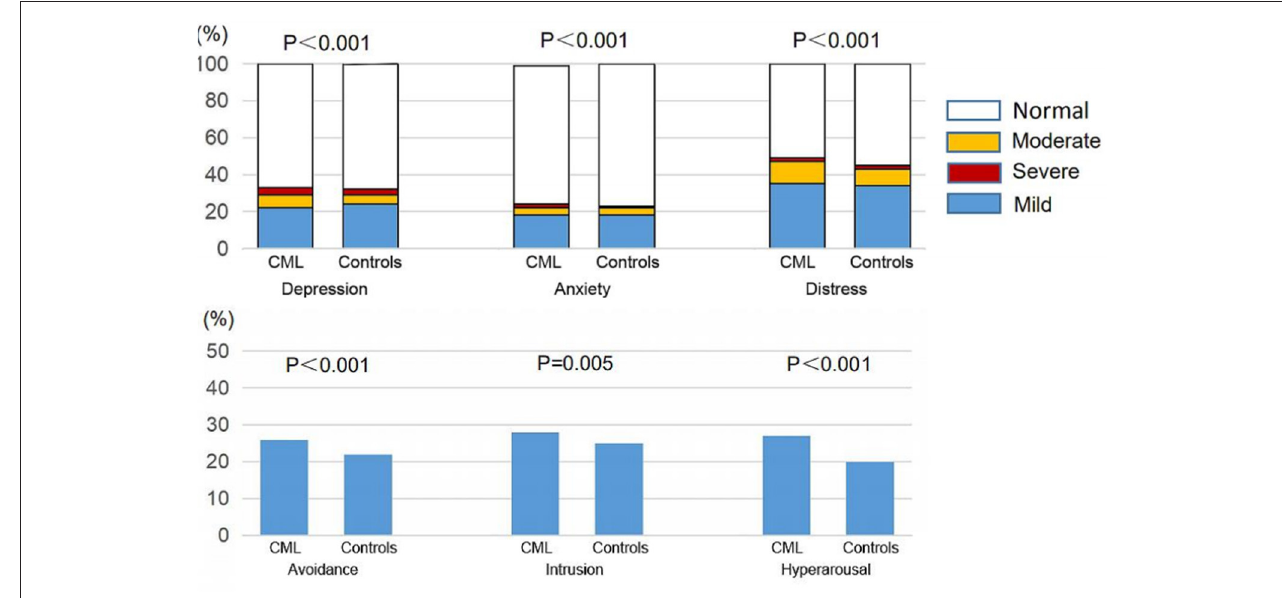
FIGURE 1 | Comparison of mental health between the respondents with CML and